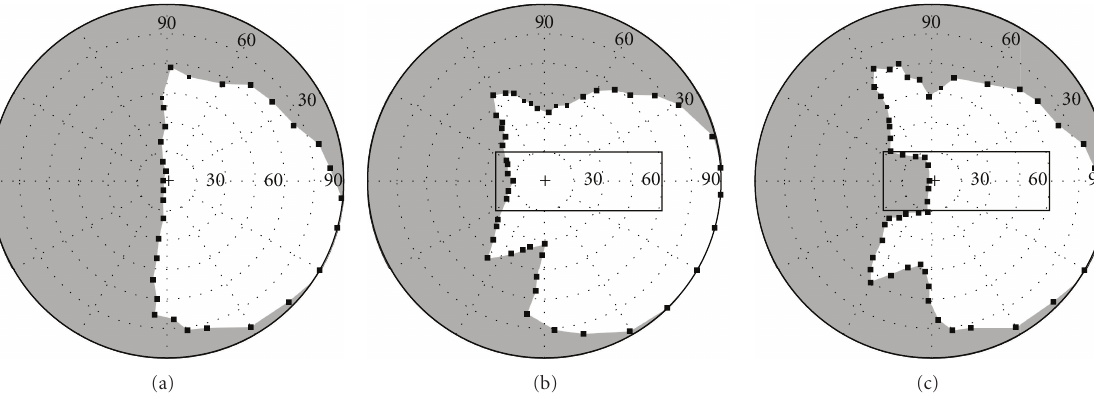
Figure 2: Binocular visual field (Goldmann V4e) of a patient with left HH (a) without peripheral prisms, (b) with 40 Δ oblique peripheral prisms as fitted for this study with no vertical separation between the expansion areas (9mm interprism separation and 30 ◦ angle of tilt), and (c) with the original horizontal design of 40 Δ peripheral prisms for walking [21] (12mm interprism separation). The oblique design provides about 20 ◦ of lateral expansion into central areas of the blind hemifield in the region used when looking through a car windshield (rectangle represents the field of view through a typical car windshield for driving on the right [22]); the horizontal design does not provide expansion within this area. Small black squares are the individual points mapped during the